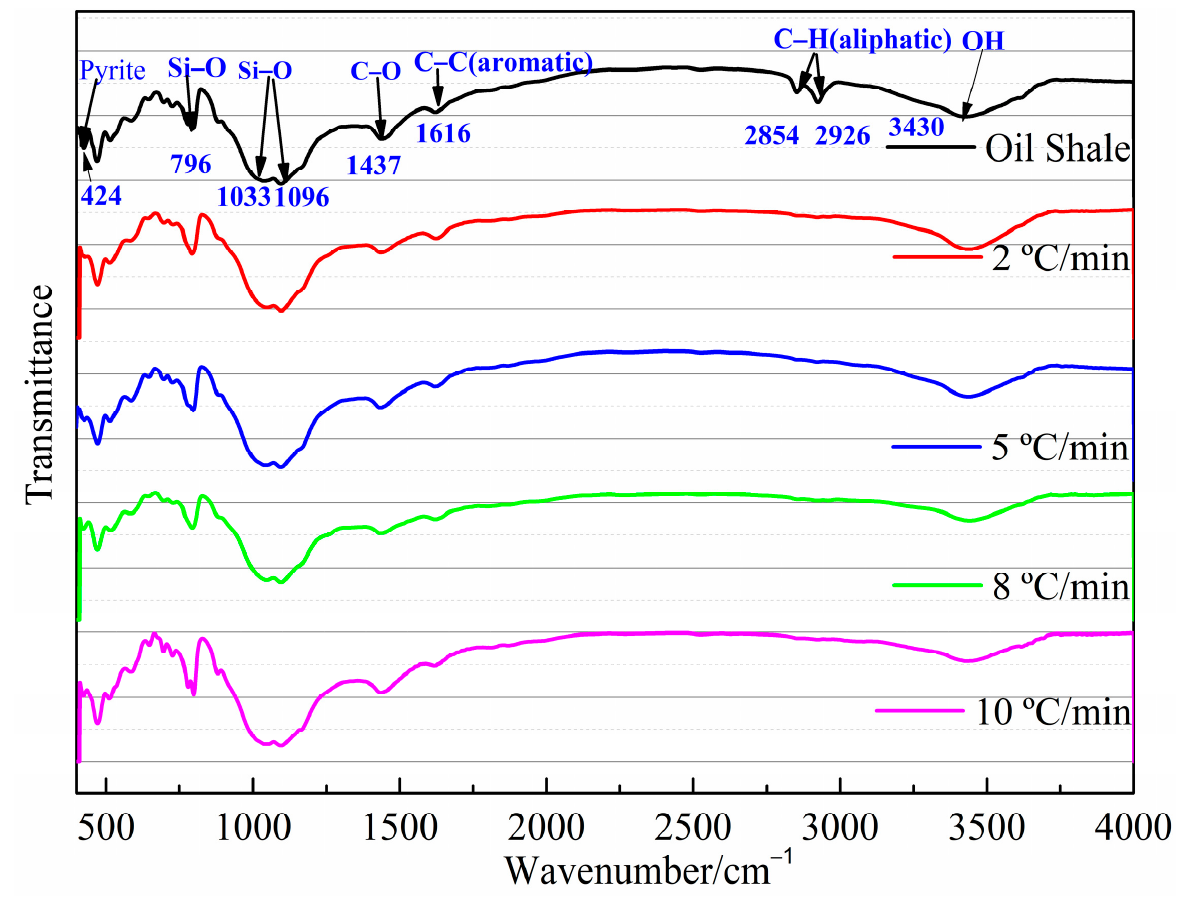
Figure 2. FT-IR spectra of Jimsar raw oil shale and its spent shale.